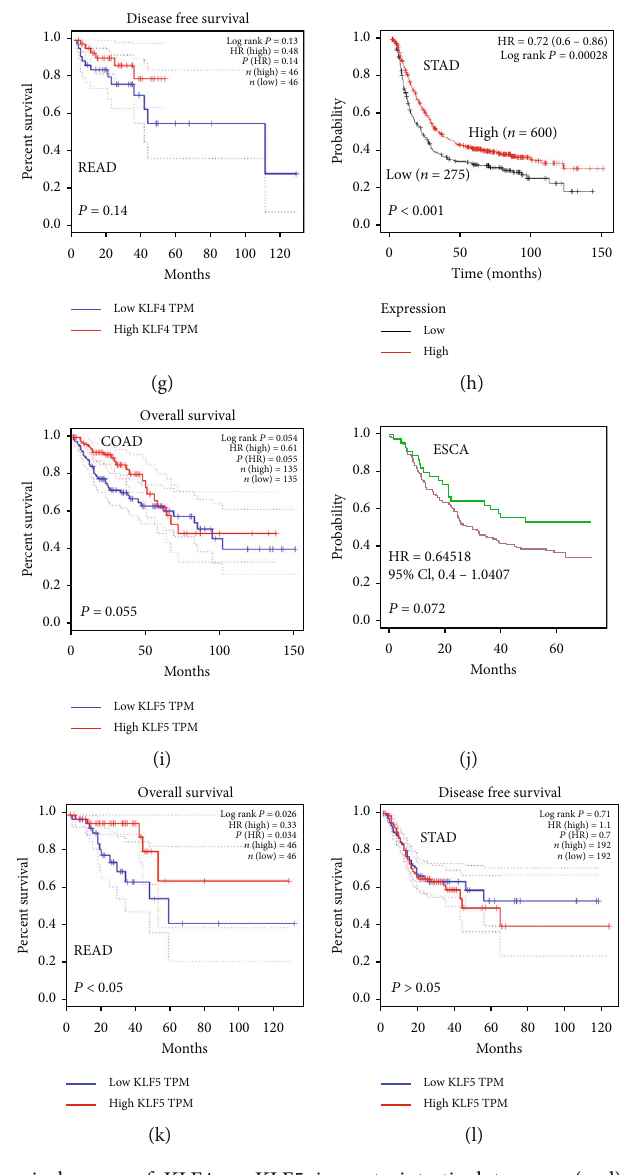
Figure 1: The expression and survival curve of KLF4 or KLF5 in gastrointestinal tumors. (a – d) Expression of KLF4 or KLF5 in gastrointestinal tumors. KLF4 was lowly expressed in COAD, ESCA, READ, and STAD tumors and had statistical signi fi cance in COAD and READ ( P < 0 : 05 ). KLF5 was highly expressed in COAD, ESCA, READ, and STAD tumors and was statistically signi fi cant in COAD, READ, and STAD ( P < 0 : 05 ). (e – h) The survival curve of KLF4 in gastrointestinal tumors. Patients with high expression of KLF4 had a good prognosis in COAD, ESCA, and STAD ( P < 0 : 05 ). (i – l) The survival curve of KLF5 in gastrointestinal tumors. Patients with high KLF5 expression had a good prognosis in READ ( P < 0 : 05 ). T means tumor and N means